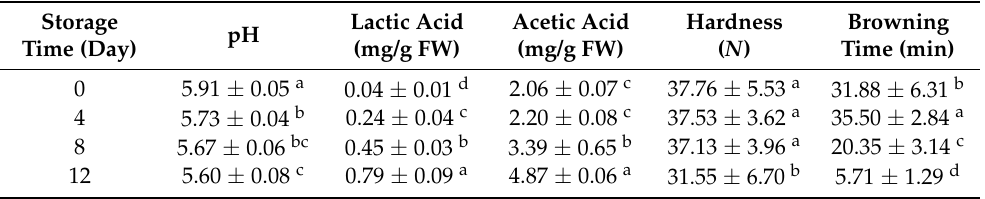
Table 1. Changes in pH, lactic acid, acetic acid content, hardness and browning time of vacuum- packaged potatoes during storage.